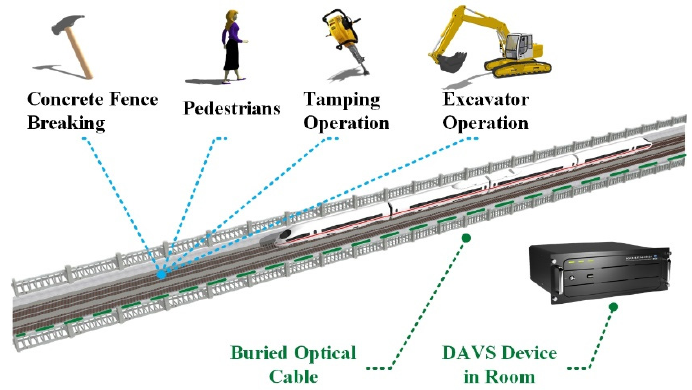
Figure 21. Safety monitoring along railway. Reproduced with permission from our previous paper [3], published by Optical Society of America, 2019.